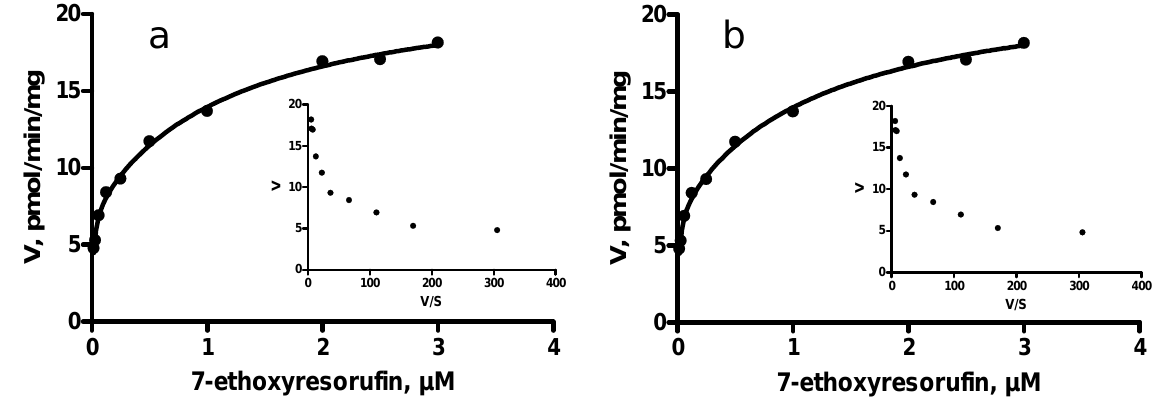
Figure 2. Saturation curve for 7-ethoxyresorufin O -deethylation by hepatic microsomes from entire (a) and castrated (b) male pigs. Insets: Eadie-Hofstee transformations of the same data. V – velocity of resorufin formation; S - substrate.